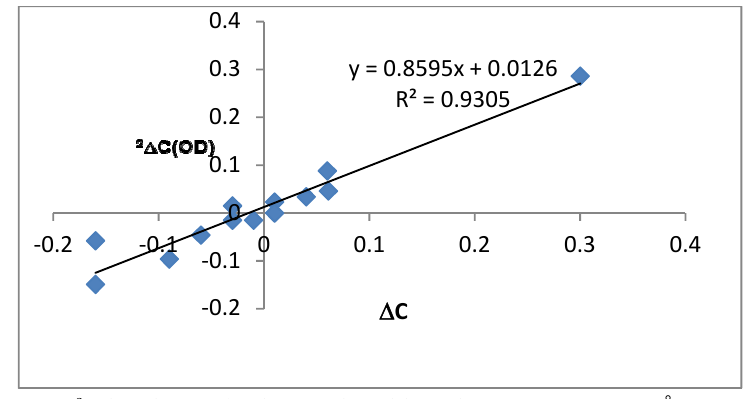
Figure 7. Plot of two-bond deuterium isotope effects on 13 C chemical shifts vs. the change in the nuclear shielding a for HBQ.